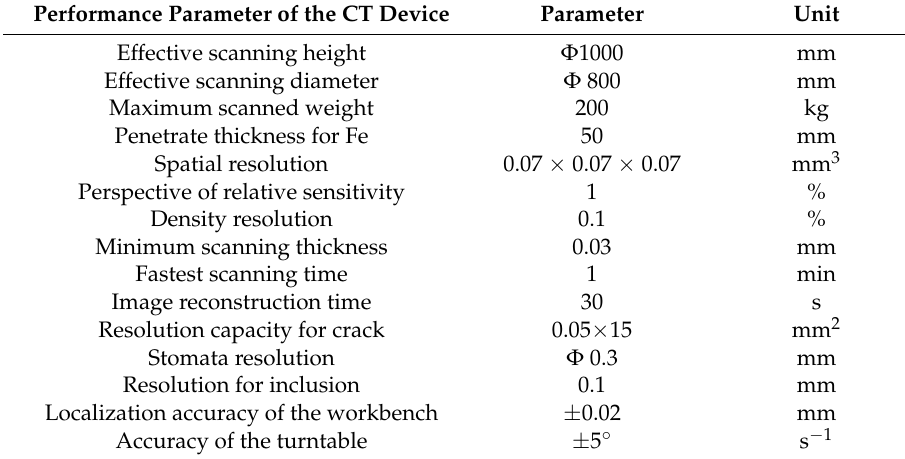
Table 2. The detailed performance index of the 450 kV industrial X-ray computed tomography (CT)